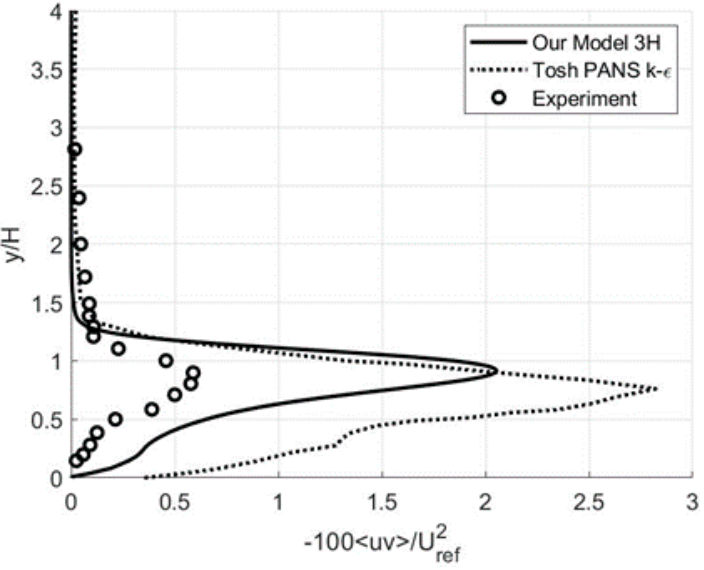
Figure 10. Mean Reynolds stress profiles at x / H = 2 from the step (𝑓 (cid:3084) = 0.667,𝑓 (cid:3038) = 0.2).